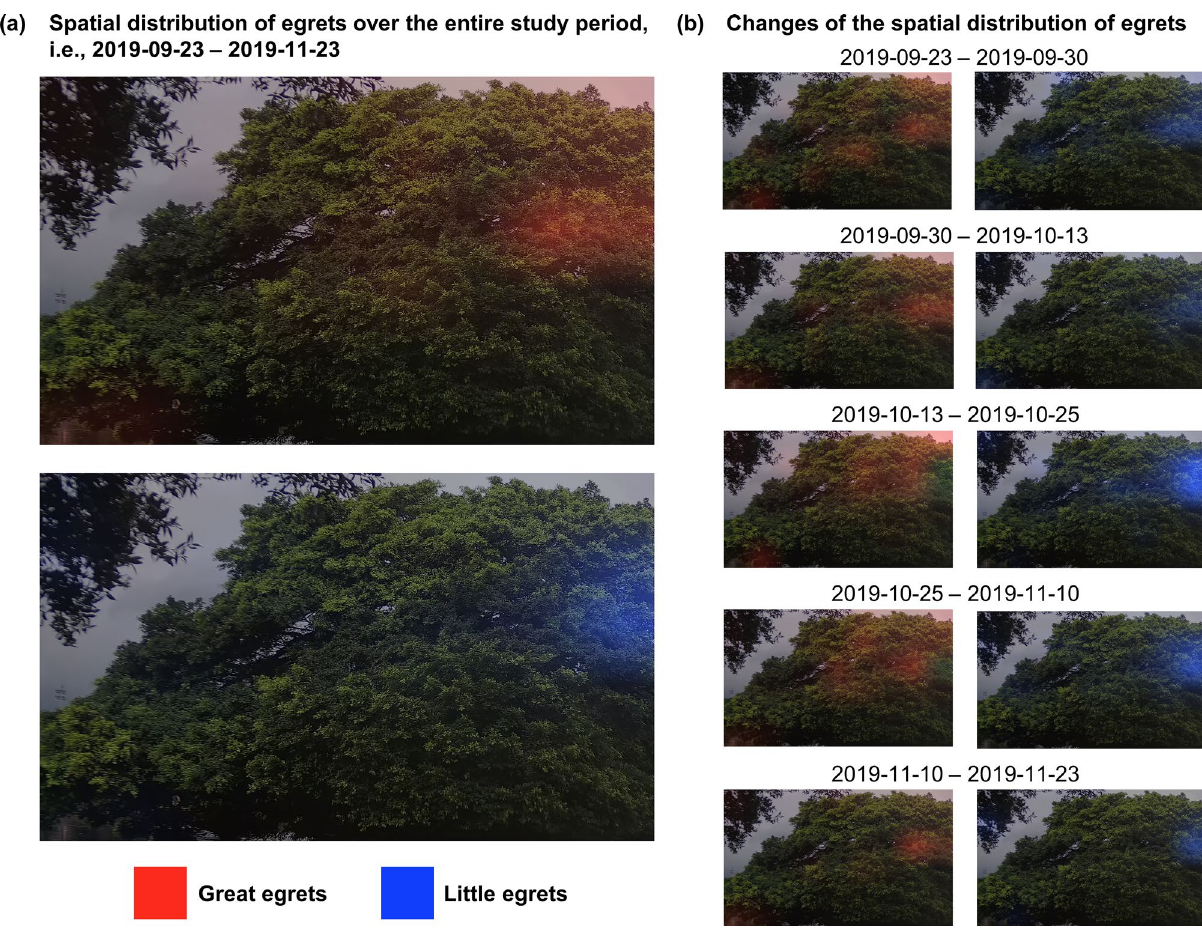
Figure 7. Spatial distribution of the great egrets (red) and little egret (blue) at the study over ( a ) the entire study period; and ( b ) the testing periods split based on the results observed at Fig. 6a to observe the associated changes. The intensity of hotspot reflects the bird counts at a region, which could be used as an indicator to study the nest site selection and habitat preference of different bird